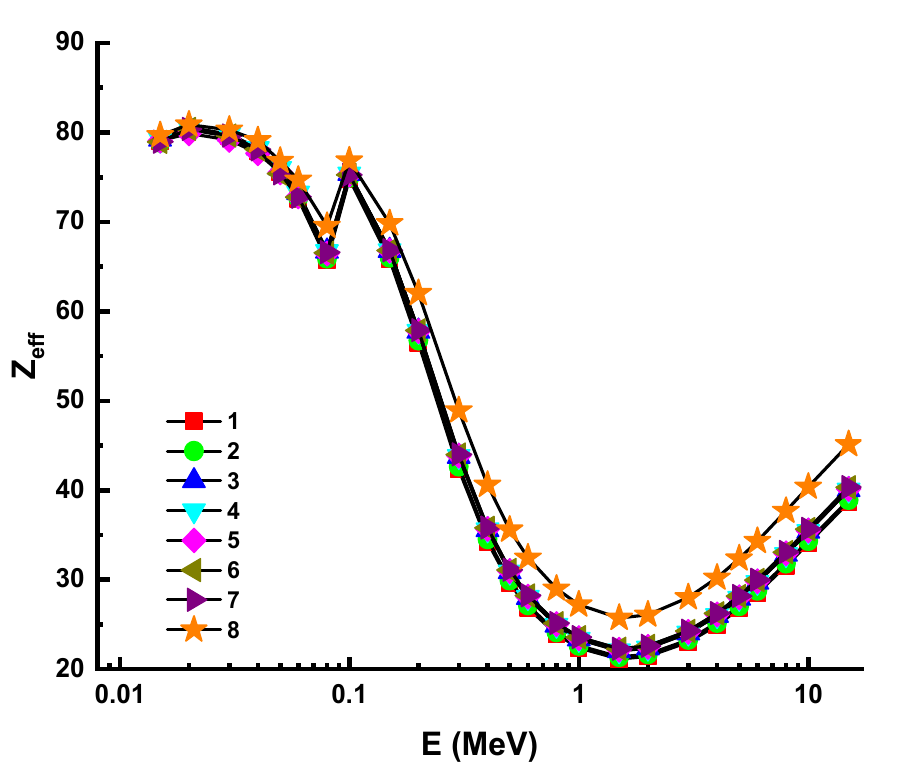
Figure 6. Variation of effective atomic number (Z eff ) against Photon energy for all glasses. 1—37.5Bi 2 O 3 –62.5B 2 O 3 ; 2—38Bi 2 O 3 –60B 2 O 3 –2Al 2 O 3 ; 3—40Bi 2 O 3 –60B 2 O 3 ; 4—40Bi 2 O 3 –59B 2 O 3 –1Al 2 O 3 ; 5—40Bi 2 O 3